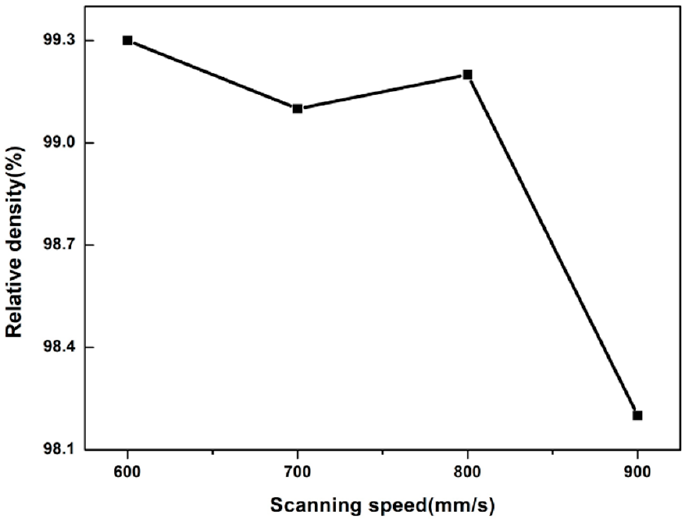
Figure 3. Variation in relative density with scanning